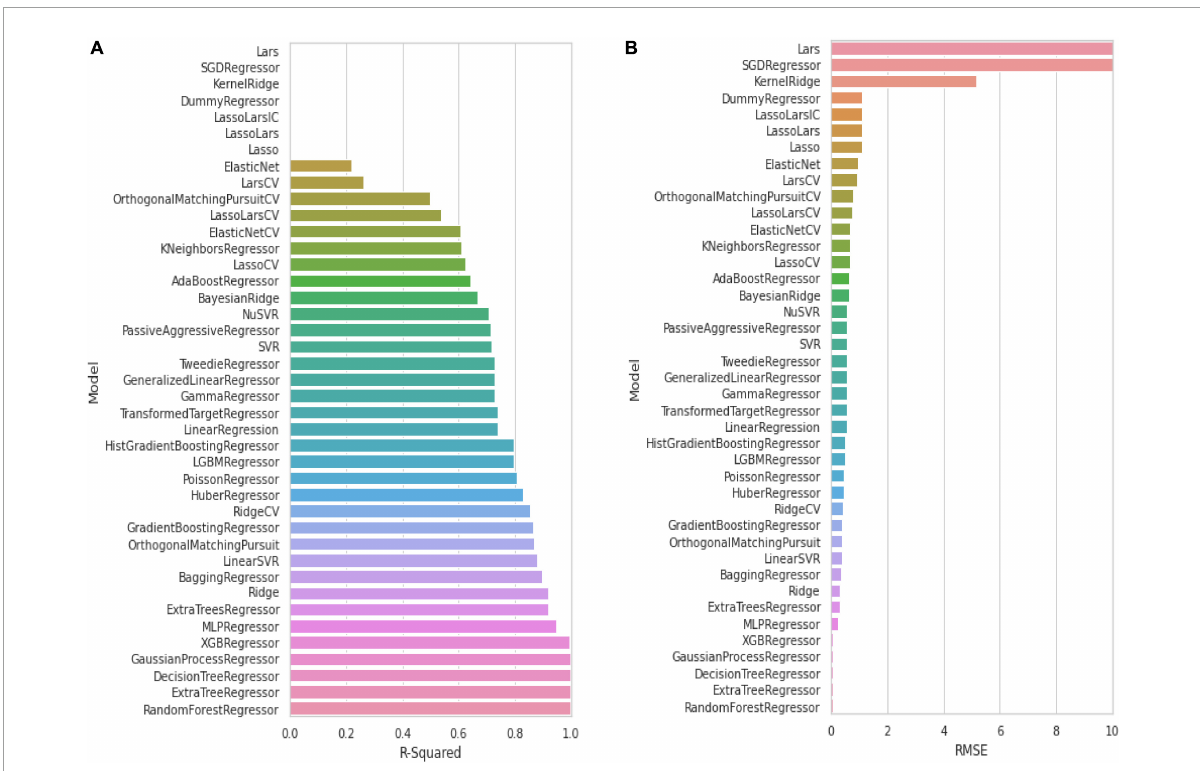
FIGURE3 Evaluation of common machine learning algorithms via using: (A) R-squared and (B) RMSE. Adopted from BioRender.com.